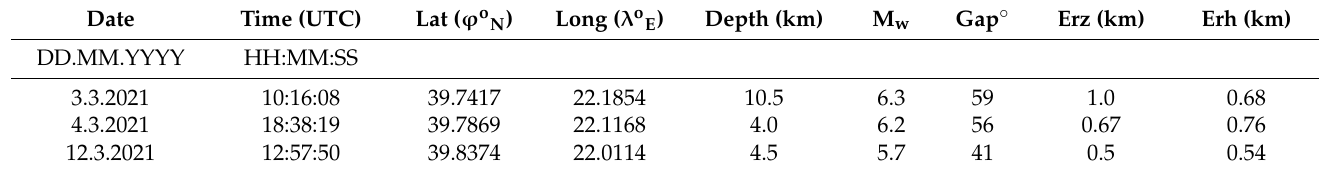
Table 3. Relocated hypocenters for the three strong